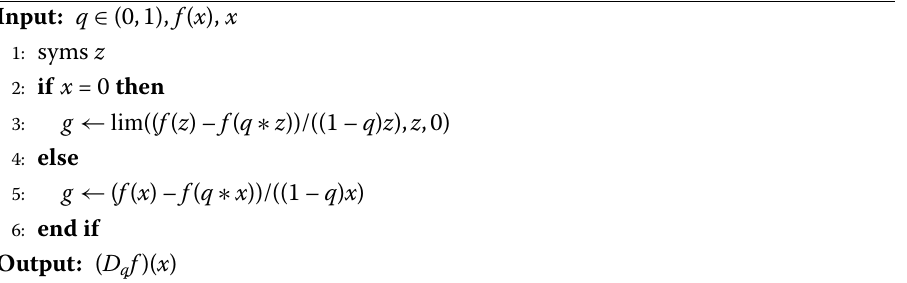
Algorithm 3 The proposed method for calculating ( D q f )( x